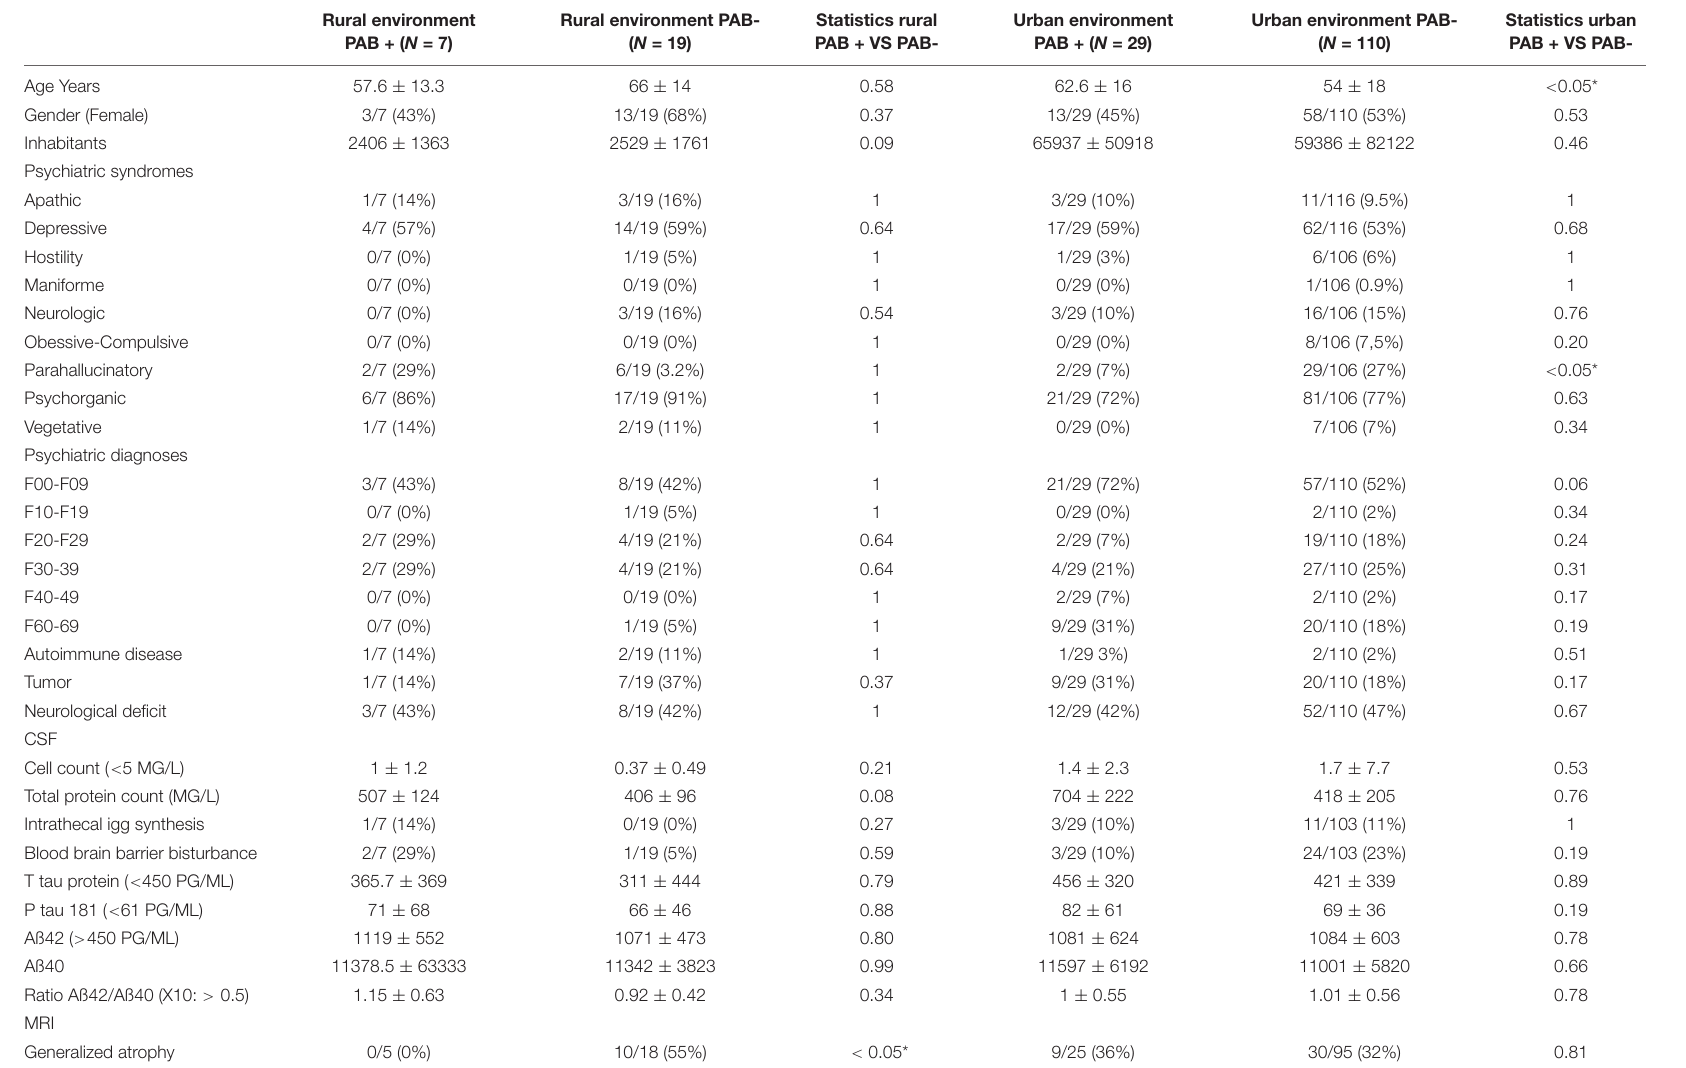
TABLE 1 | Demographic, clinical, and laboratory data of patient